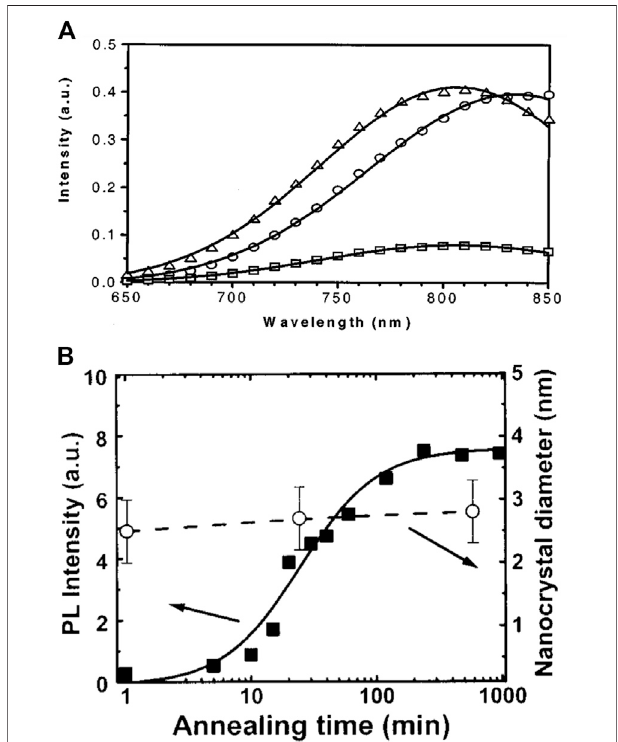
FIGURE 4 | (A) PL spectra of SiNCs/SiO 2 after annealing at 1,100 ° C in N 2 ( □ ) and after an additional anneal at 500 ° C in forming gas (N 2 +H 2 ) ( ○ ). The spectrum for the sample annealed at 1,100 ° C in N 2 has been multiplied by a factor of 5 to highlight the redshift ( △ ). The solid lines represent the Gaussian fi t to the data, reprinted with permission from Cheylan and Elliman. (2001). Copyright 2001 American Institute of Physics. (B) PL intensity of SiNCs/SiO 2 at 1.7 eV (left axis) and the SiNCs ’ mean size from TEM analysis (rightaxis) vs.annealingtimeat1,100 ° CinN 2 ,reprintedwithpermissionfrom López et al. (2002). Copyright 2002 American Institute of